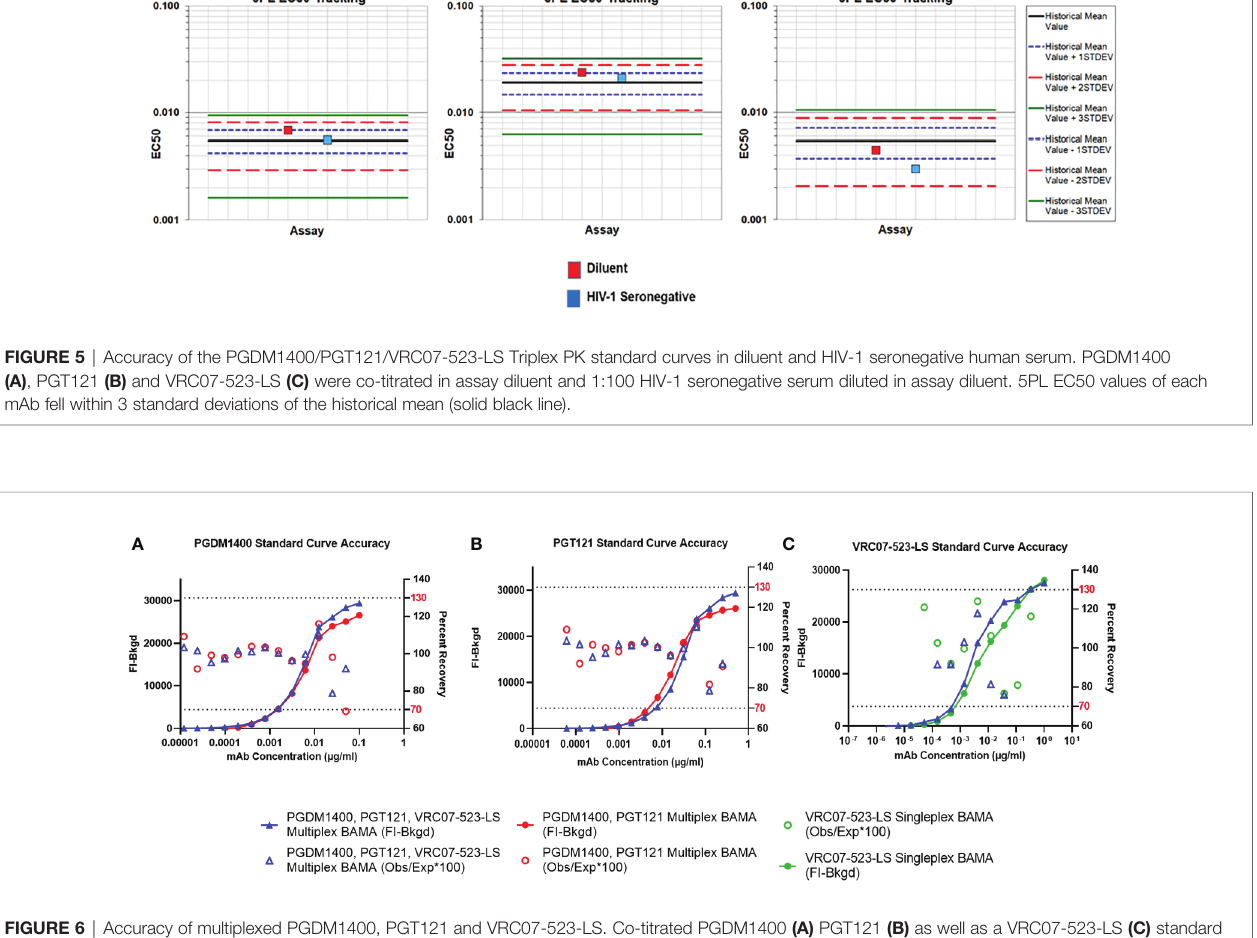
FIGURE 6 | Accuracy of multiplexed PGDM1400, PGT121 and VRC07-523-LS. Co-titrated PGDM1400 (A) PGT121 (B) as well as a VRC07-523-LS (C) standard curve (all from validated assays) are compared to the co-titrated PGMD1400/PGT121/VRC07-523-LS standard curve. All three curves were titrated in 1:100 NHS diluted in assay diluent and FI-Bkgd as well as percent recovery were compared. Curves and percent recovery are comparable indicating that VRC07-523-LS does not bind to any other anti-ID other than the one speci fi c to VRC07-523-LS.